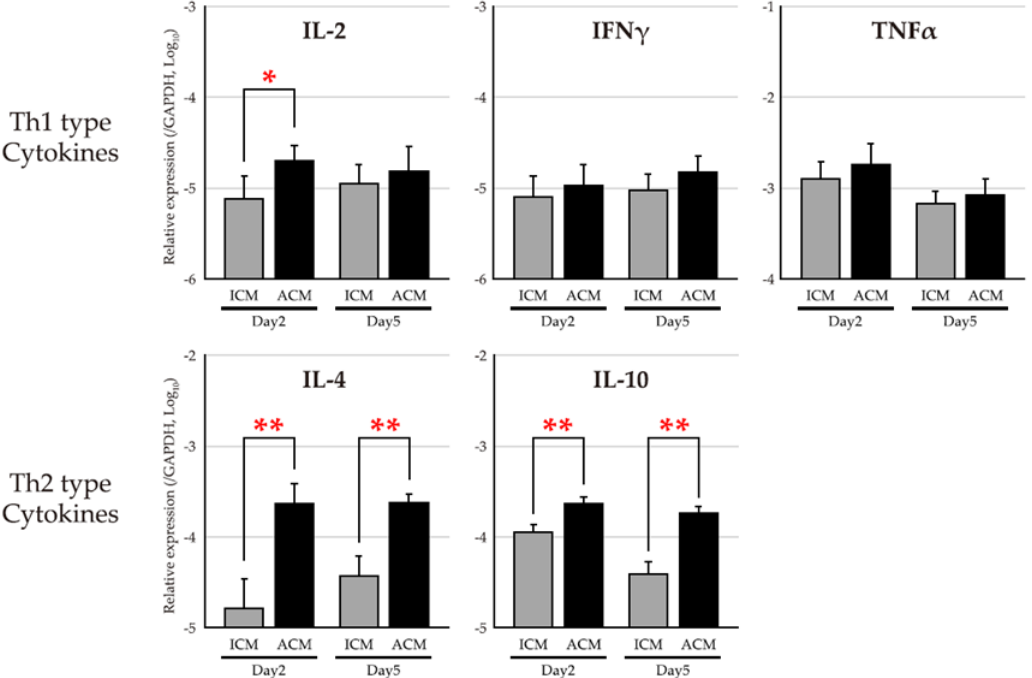
Figure 4. mRNA expression levels of Th1– and Th2–type cytokines in the mucosa of Pd–induced allergic mice. The mRNA expression levels of Th1–type cytokines (IL–2, IFN γ , and TNF α ) and Th2 type cytokines (IL–4 and IL–10) were assessed in the OM of ICM (gray bars) and ACM (black bars) mice ( n = 5) on days 2 and 5 after the challenge. Each sample was divided by GAPDH gene expression as an internal control. Bars and error bars indicate the mean plus standard deviation. Statistical significance was tested by the Mann – Whitney U test (* p < 0.05, ** p < 0.01).